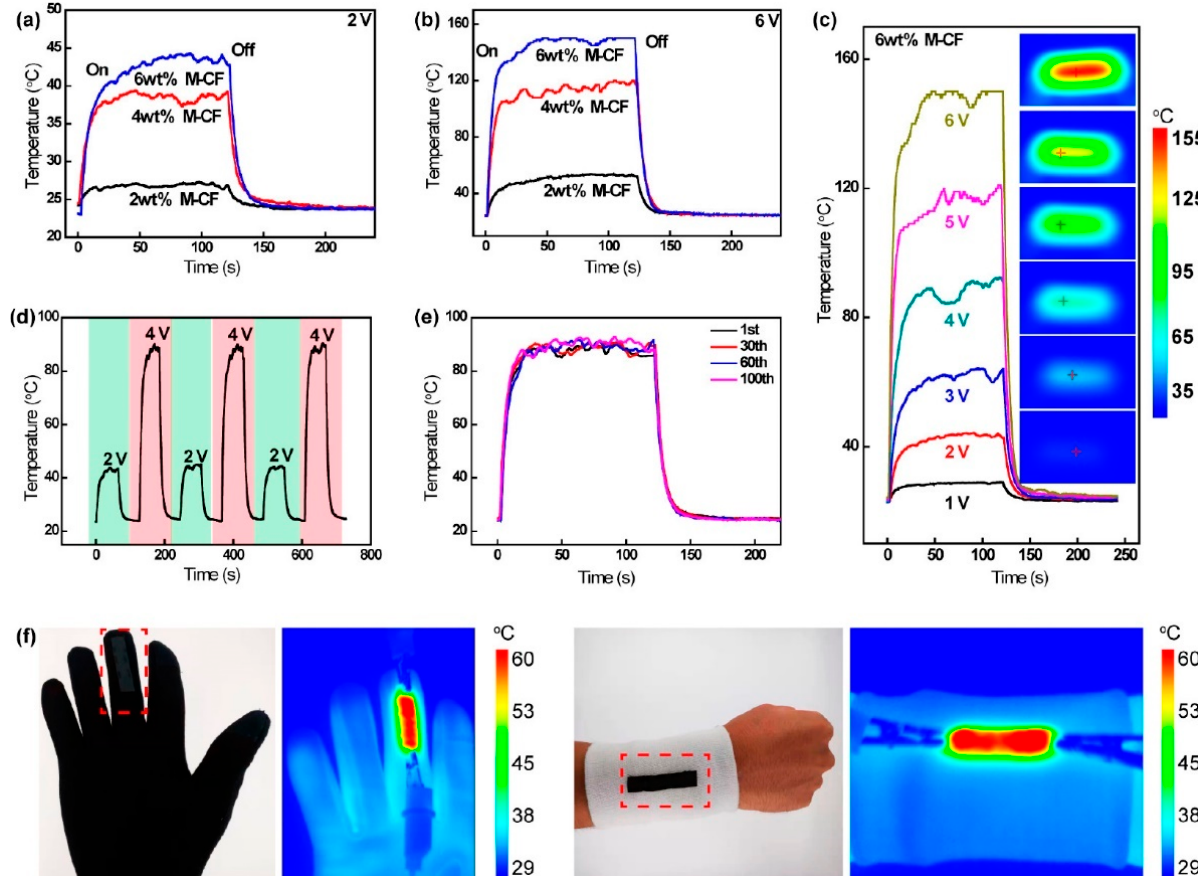
Figure 6. A piece of flexible MXene-decorated fabric with interwoven conductive networks for integrated Joule heating, electromagnetic interference shielding and strain sensing performances: Time–temperature curves of M-C fabrics at a voltage of ( a ) 2 and ( b ) 6 V. ( c ) Time–temperature curves of 6 wt % M-CF from 1 to 6 V. ( d ) Temperature adjustability of the 6 wt % M-CF heater. ( e ) Temperature stability of 6 wt % M-CF heater under 100 heating cycles. ( f ) Temperature distribution of the wearable 6 wt % M-CF heater attached on a glove and wrist [141].